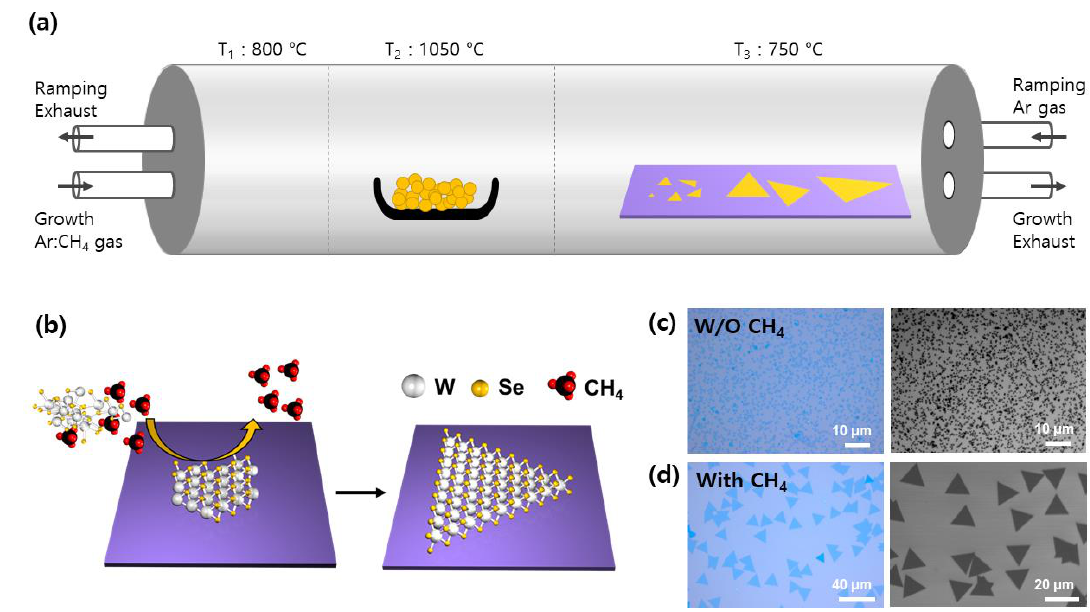
Figure 1. The schematic illustration of methane-mediated WSe 2 synthesis. ( a ) Sketch of homemade tube-type chemical vapor deposition (CVD) setup. ( b ) Schematic image of WSe 2 crystal growth by vapor-solid transport mechanism and its growth morphology difference between ( c ) without and ( d ) with methane (CH 4 ) gas.